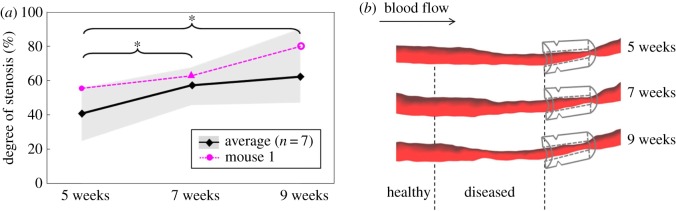
(a) Degree of stenosis of RCCA at 5, 7 and 9 weeks after cast placement: average of seven animals (black line, *p < 0.05, repeated-measures ANOVA); mouse 1 (pink line); shadow area indicates data range of seven animals. Notably, animals exhibited various plaque progression profiles. (b) Three-dimensional reconstruction of RCCA at 5, 7 and 9 weeks after cast placement of mouse 1. Direction of blood flow is indicated by the arrow in the upper left corner. Location of the cast is illustrated. Upstream to the cast, the RCCA is divided into a healthy segment and a diseased segment based on the week 9 histology data. Lumen narrowing can be observed over time, suggesting the development and progression of a lumen intruding plaque.